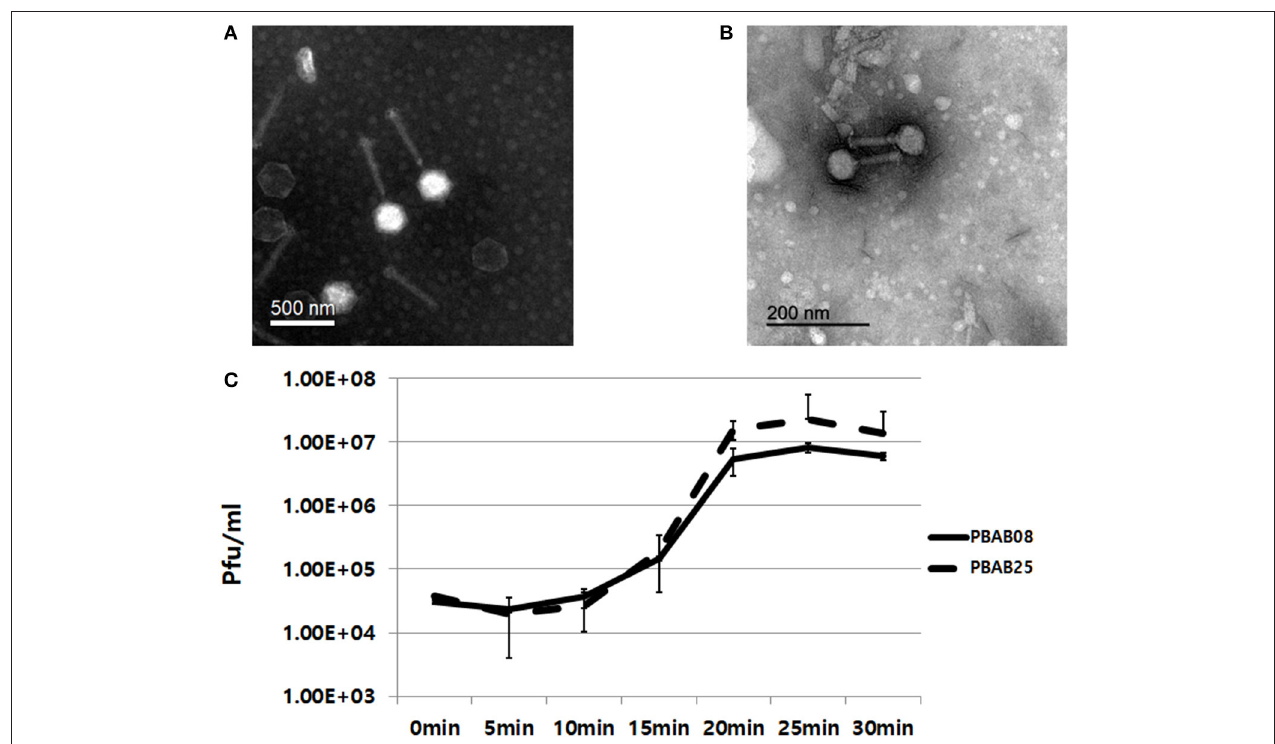
FIGURE 1 | Transmission electron micrographs of bacteriophages PBAB08 (A) and PBAB25 (B) . Samples were negatively stained with uranyl acetate. Scale bar is shown in each picture. (C) One step multiplication of phages PBAB08 (solid line) and PBAB25 (broken